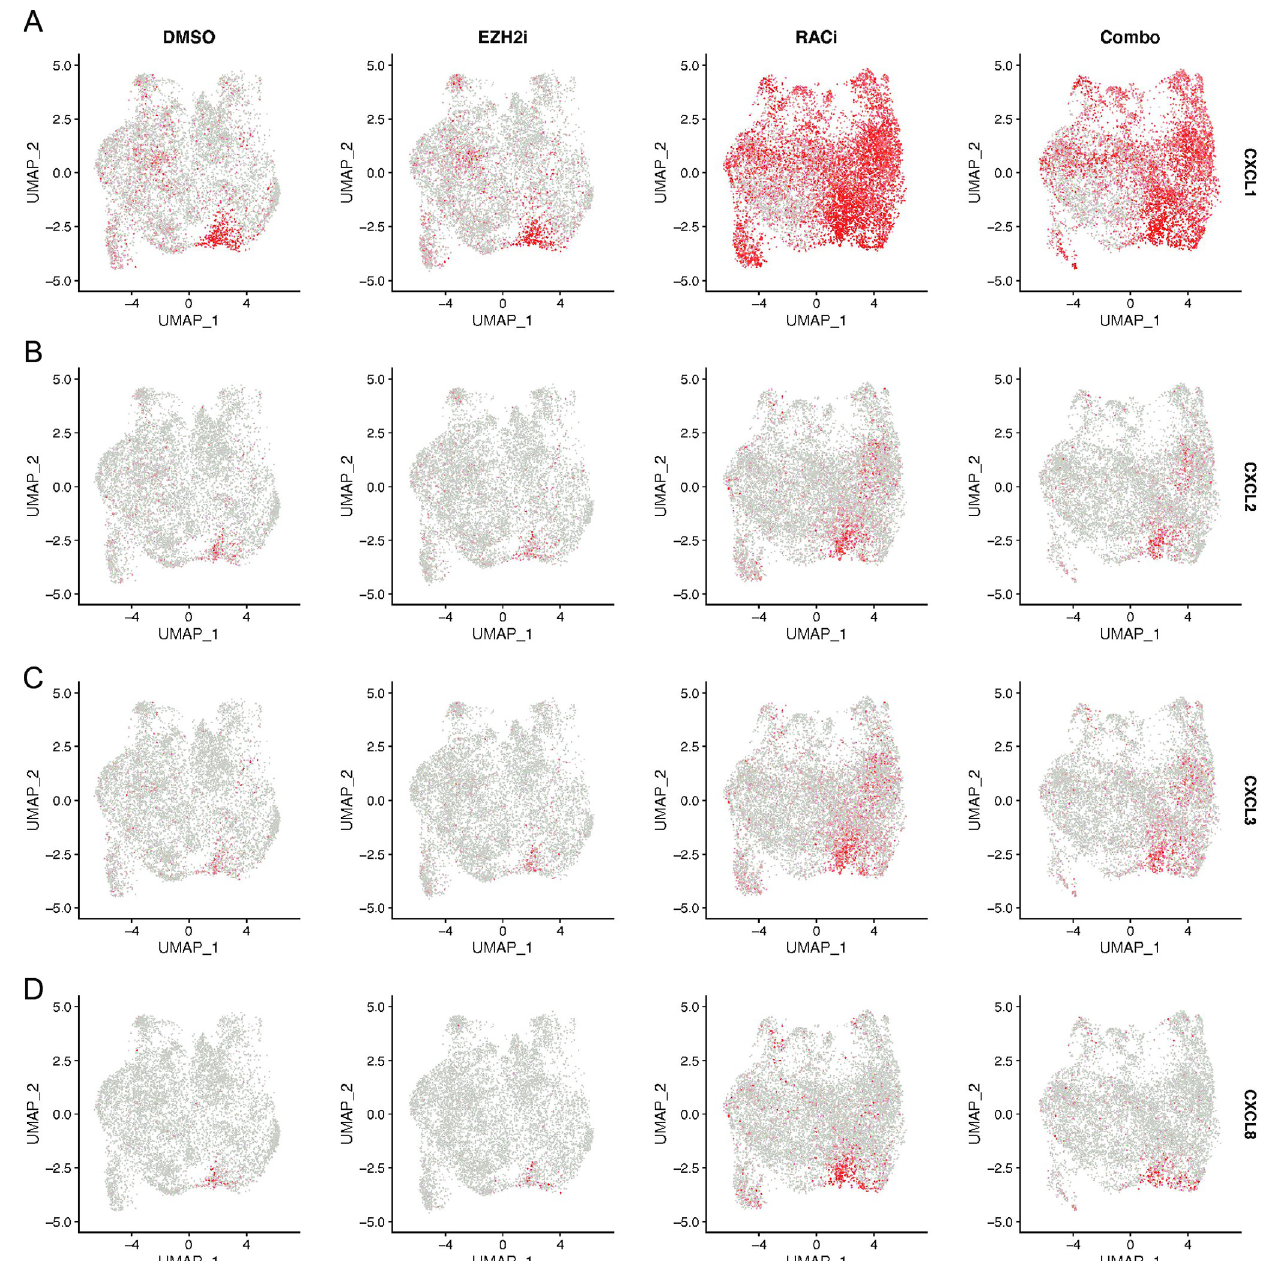
Fig 3. RAC1i treatment results in broader expression of inflammatory genes. (A-D) UMAP dot plots of normalized expression values of CXCL1 (A), CXCL2 (B), CXCL3 (C) and CXCL8 (D) in the indicated sample types.